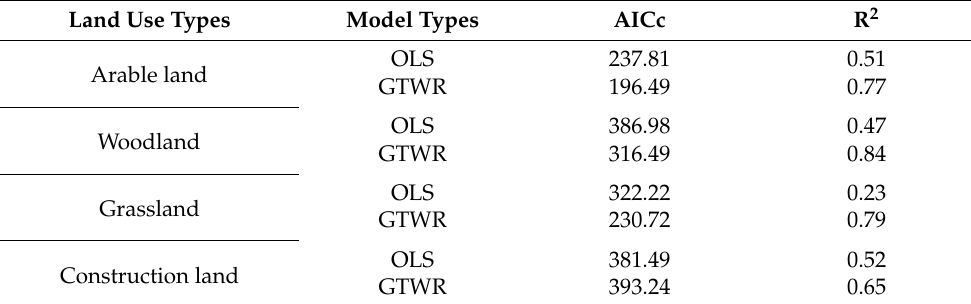
Table 3. Parameters from ordinary least squares (OLS) and geographically and temporally weighted regression (GTWR)